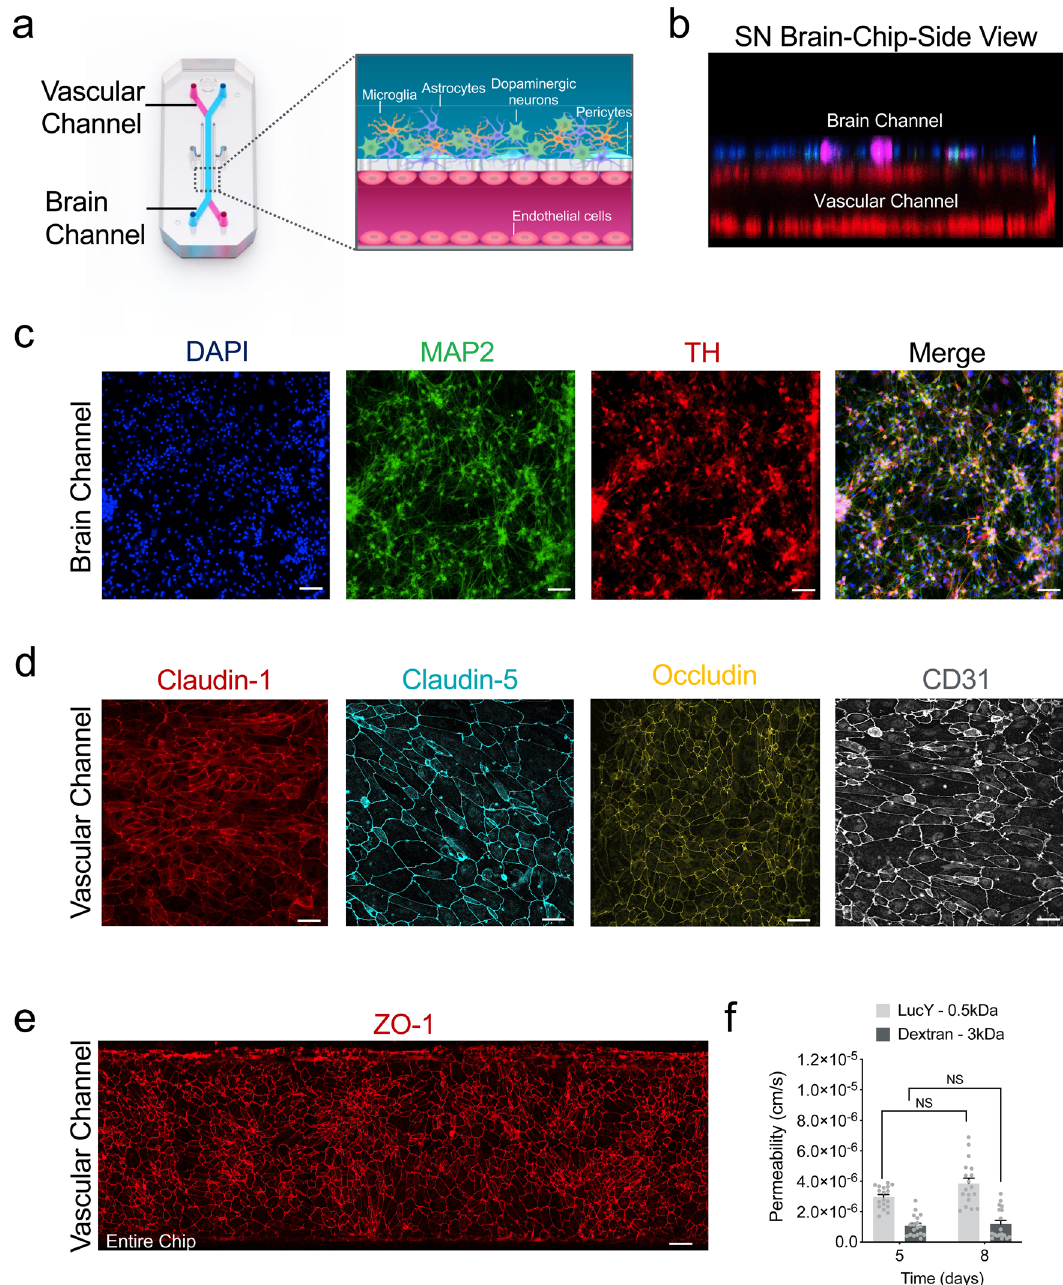
Fig. 1 Reconstitution of the human substantia nigra Substantia Nigra Brain-Chip. a Schematic depiction of the Substantia Nigra Brain-Chip of a two-channel microengineered chip with iPSC-derived brain endothelial cells cultured on all surfaces of the lower vascular channel, and iPSC-derived dopaminergic neurons, primary human brain astrocytes, microglia, and pericytes on the upper surface of the central horizontal membrane in the upper brain channel. b 3D reconstruction of a confocal z-stack showing the organization of all fi ve cell types in the Substantia Nigra (SN) Brain-Chip. c Representative image of iPSC-derived dopaminergic neurons that are stained with DAPI (blue), microtubule-associated protein 2 (green, MAP2), tyrosine hydroxylase (red, TH), and a merged image on day 8. Scale bars: 100 μ m. d Immuno fl uorescence micrographs of the human brain endothelium cultured on the vascular channel of Brain-Chip for 7 days post-seeding (D8) labeled with Claudin-1 (red), Claudin-5 (cyan), Occludin (yellow), and CD31 (white). Scale bars: 100 μ m. e Immuno fl uorescence micrographs demonstrate high levels of expression of zonula occludens-1 (red, ZO-1) across the entire endothelial monolayer. Scale bars: 100 μ m. f Quantitative barrier function analysis via apparent permeability to 3kDa fl uorescent dextran, and 0.5kDa lucifer yellow (LucY) crossing through the vascular to the neuronal channel on day 5 and 8. Statistical analysis is two-way ANOVA with Tukey ’ s multiple comparisons test ( n = 18 independent chips, NS not signi fi cant). Error bars represent